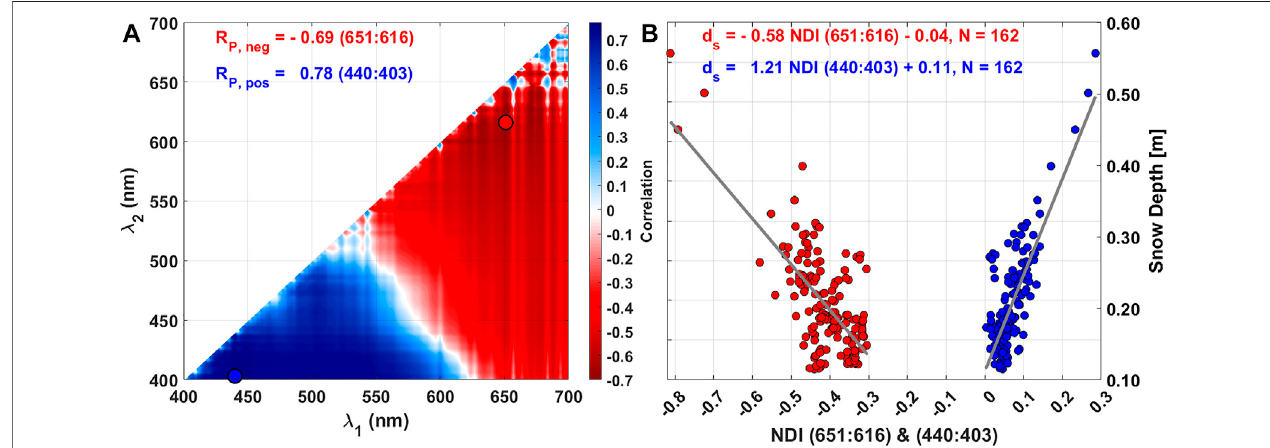
FIGURE 4 | (A) Spectral correlation surface constructed from the Pearson correlation coef fi cients R p between the NDIs and measured snow depth for all possible wavelength pairs λ 1 and λ 2 . Trans fl ectance and laser scanner snow depth were measured along the transect on May 12. (B) Corresponding linear regression between the NDIs for the wavelength pairs yielding the highest correlations (circlesin A) and the snow depth. The regression functions used to retrieve the snow depth d s are also provided. N is the number of measurements